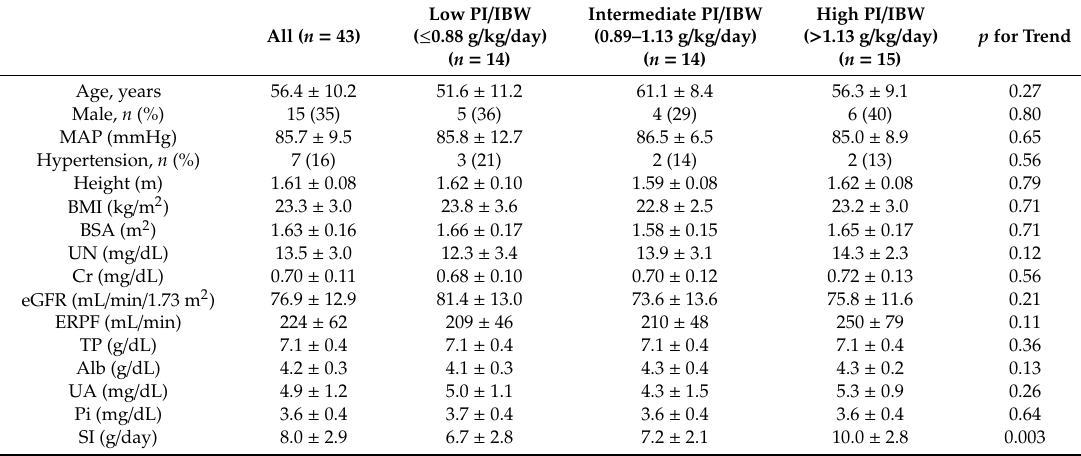
Table 1. Clinical characteristics of living kidney donors at the time of donation in the entire cohort and in groups according to the tertiles of protein intake per ideal body weight.